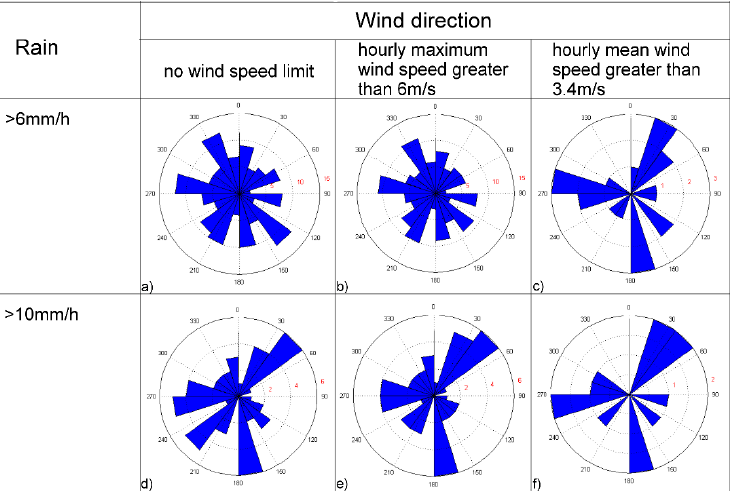
Figure 8. ( a ) Wind directions during hourly rainfall events greater than 6 mm; ( b ) wind directions during rainfall rates greater than 6 mm/h and hourly maximum wind speeds greater than 6 m/s; ( c ) wind directions during rainfall rates greater than 6 mm/h and hourly mean wind speeds greater than 3.4 m/s; ( d ) wind directions during hourly rainfall rates greater than 10 mm; ( e ) wind directions during rainfall rates greater than 10 mm/h and hourly maximum wind speeds greater than 6 m/s; and ( f ) wind directions during rainfall rates greater than 10 mm/h and hourly mean wind speeds greater than 3.4 m/s. The number of hours is shown in red.